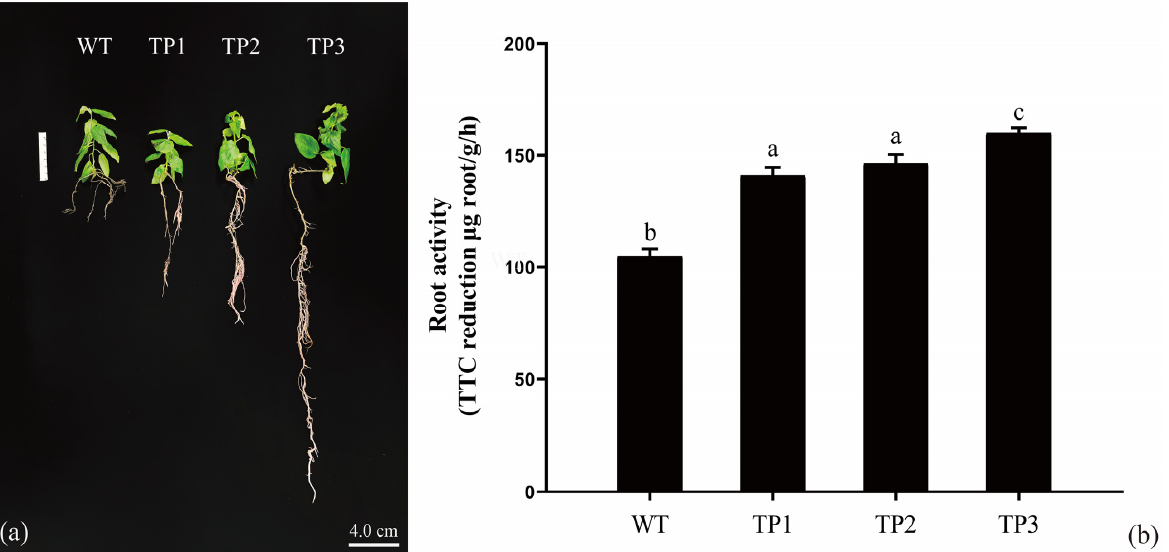
Figure 5. The e ff ect of OsCYP85A1 overexpression on the root development of transgenic plants. ( a ) Phenotype of 5-week-old seedlings under normal conditions. ( b ) The metabolic activity of transgenic plant roots was estimated by tetrazolium chloride (TTC) reduction. Error bars represent mean ± SD of three biological replicates. Di ff erent le tt ers indicate a signi fi cant di ff erence using the Tukey–Kramer test: p < 0.05.